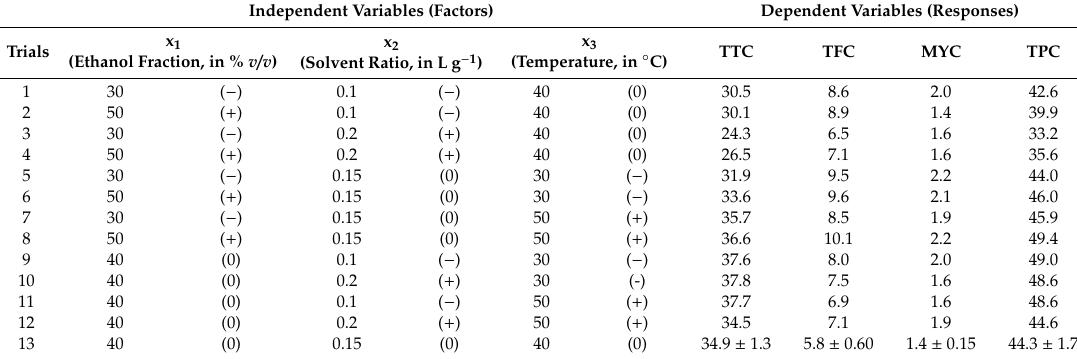
Table 2. Box–Behnken design (BBD) matrix with natural and coded values for the independent variables and responses. Fifteen experimental trials were conducted with triplicates of the central point (trial